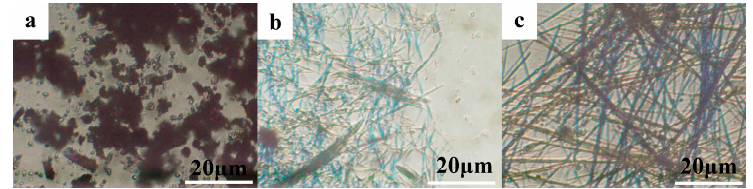
Figure 5. Optical microscope images of PBI-1 aggregates assembled in p-toluenesulfonic acid. ( a ) r = 0:1, ( b ) r = 50:1 and ( c ) r = 10,000:1.